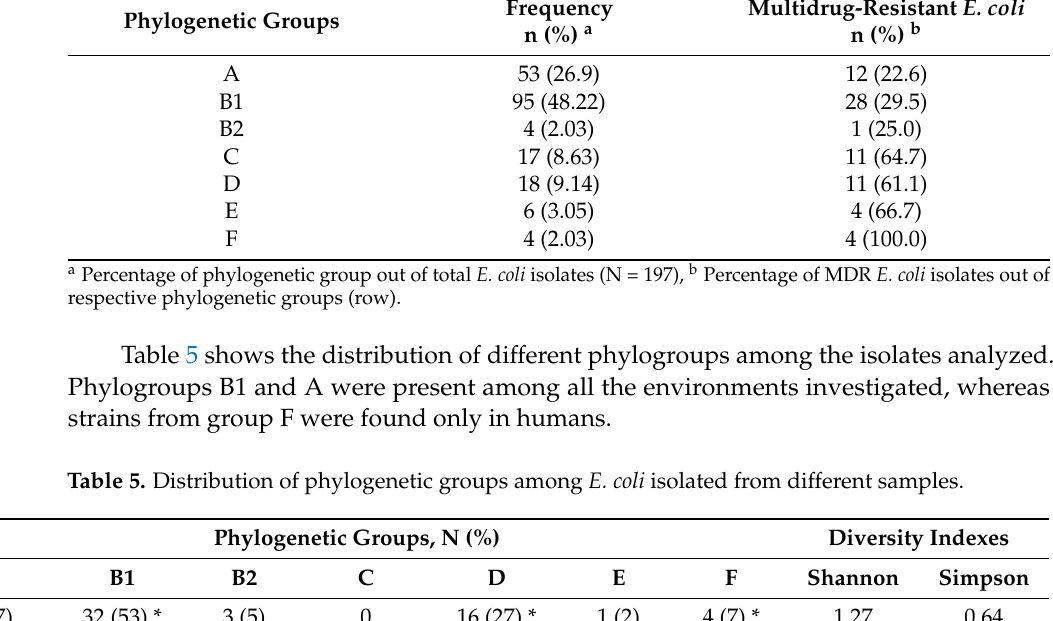
Frequency Multidrug-Resistant E. coli n (%) a